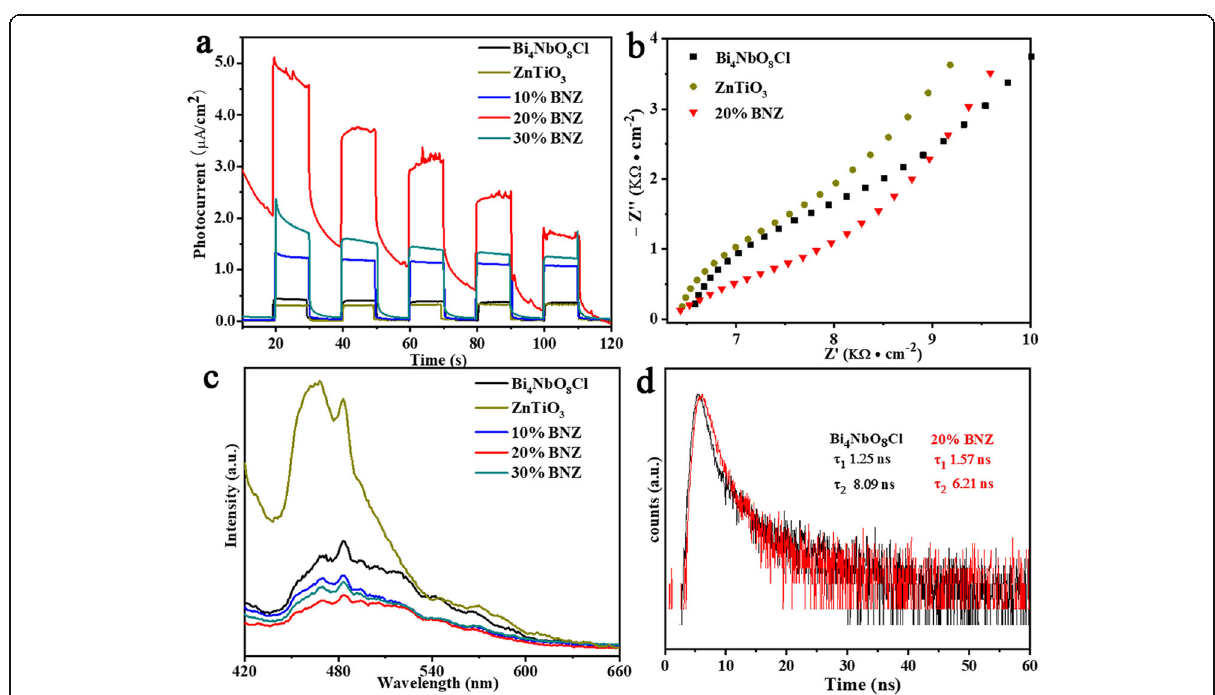
Fig. 4 a Transient-photocurrent responses of ZnTiO 3 , Bi 4 NbO 8 Cl, and BNZ samples. b Electrochemical impedance spectroscopy of ZnTiO 3 , Bi 4 NbO 8 Cl, and 20% BNZ. c Photoluminescence spectra of ZnTiO 3 , Bi 4 NbO 8 Cl, and BNZ samples. d Time-resolved PL spectra of Bi 4 NbO 8 Cl and 20%